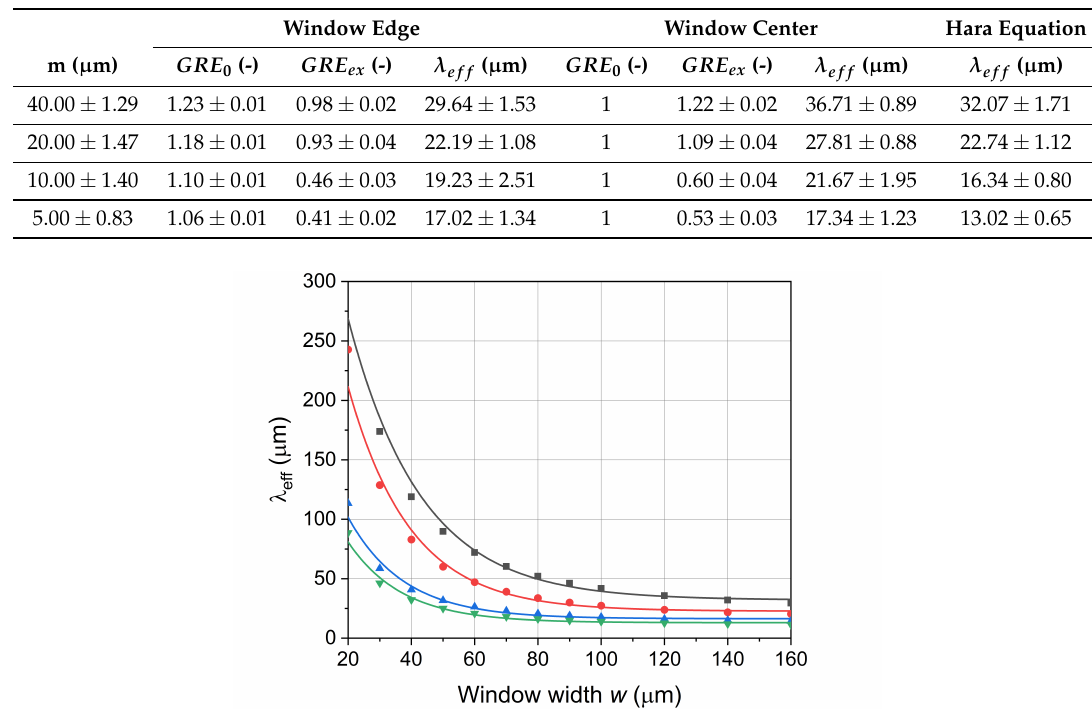
Table 1. Estimated parameters of the GRE = f ( w ) relation at the window edge and at the window center for different mask widths.